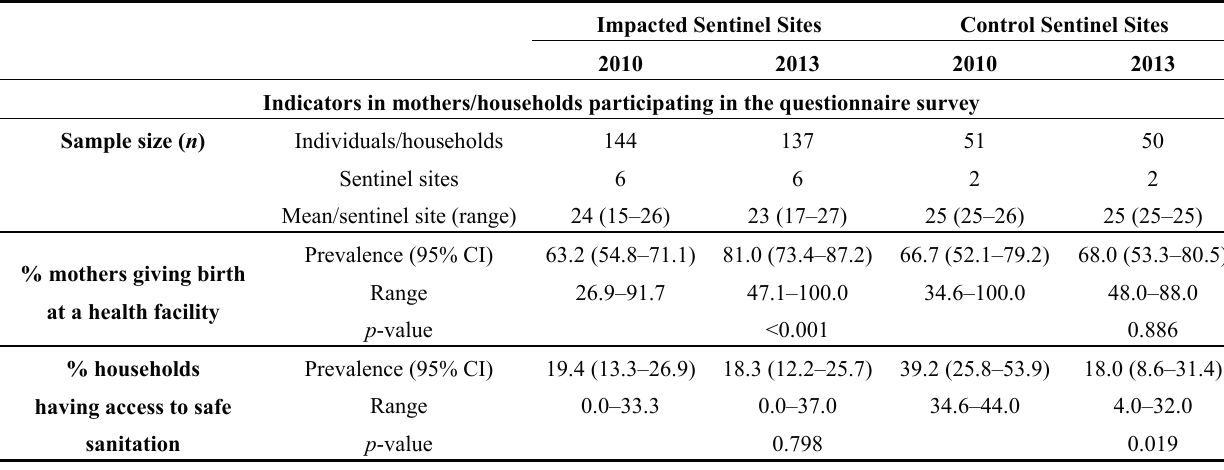
Table 3. Percentage of mothers giving birth at a health facility and the percentage of households having access to safe sanitation, in the ABSL study area, 2010 and 2013. Impacted Sentinel Sites Control Sentinel